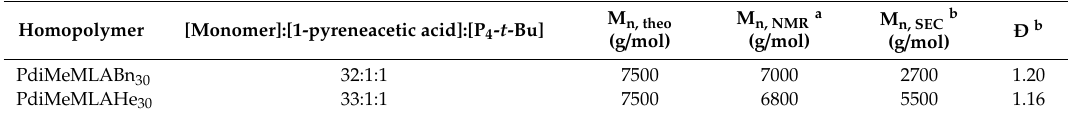
Table 1. Characteristics of PdiMeMLABn 30 and PdiMeMLAHe 30 .